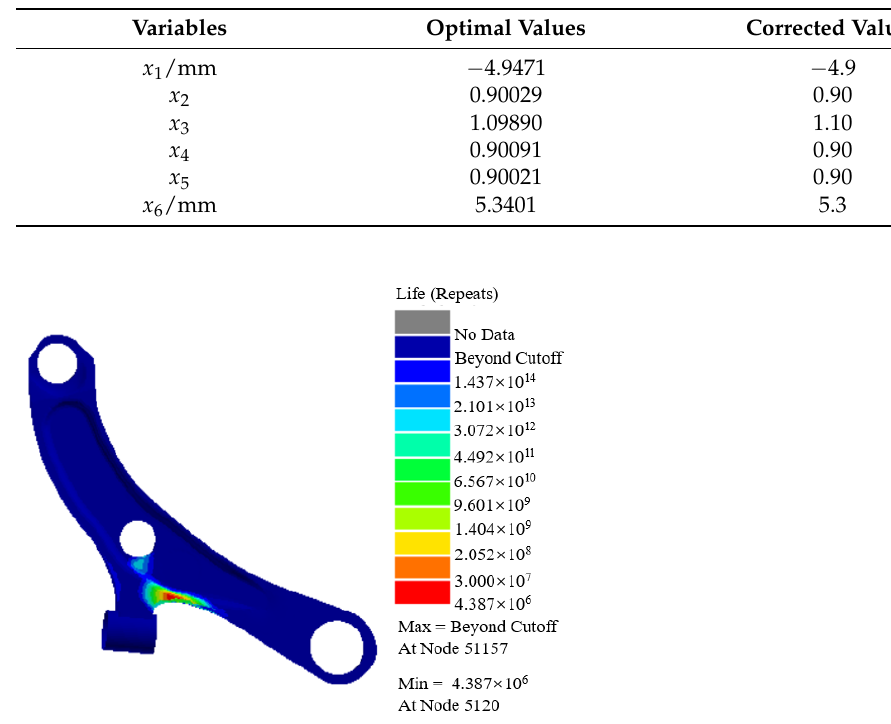
Table 7. Multi-objective reliability optimization results.